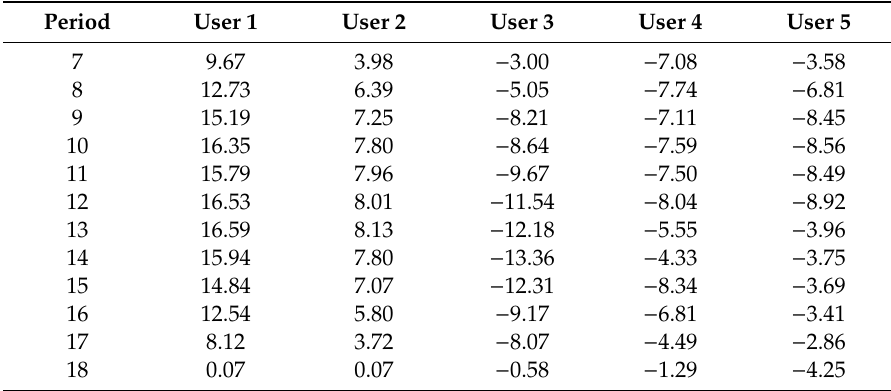
Table 10. Net PV power (kW · h).